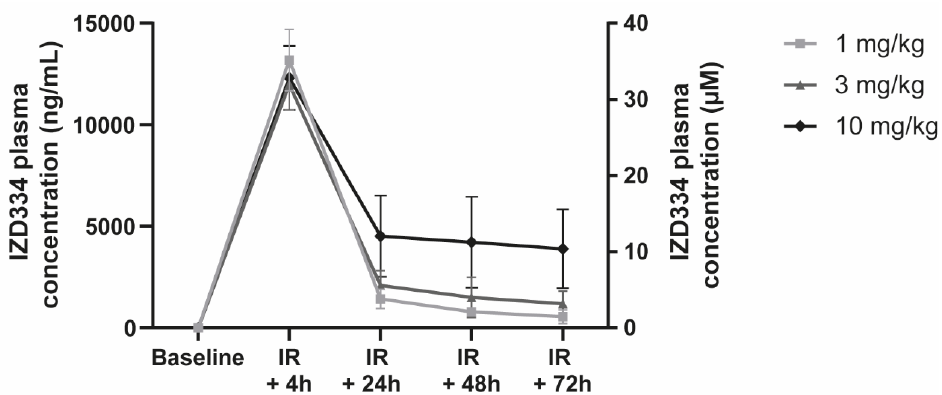
Figure 9. In vivo IZD334 plasma concentration measurements. Plasma measurements of IZD334 levels revealed peak concentrations 4 h (h) post-IR in all groups, consistent with an initial dosing of 10 mg/kg. Plasma levels during follow-up were consistent within each group and increased with dose across the dose range (1, 3, and 10 mg/kg IZD334).